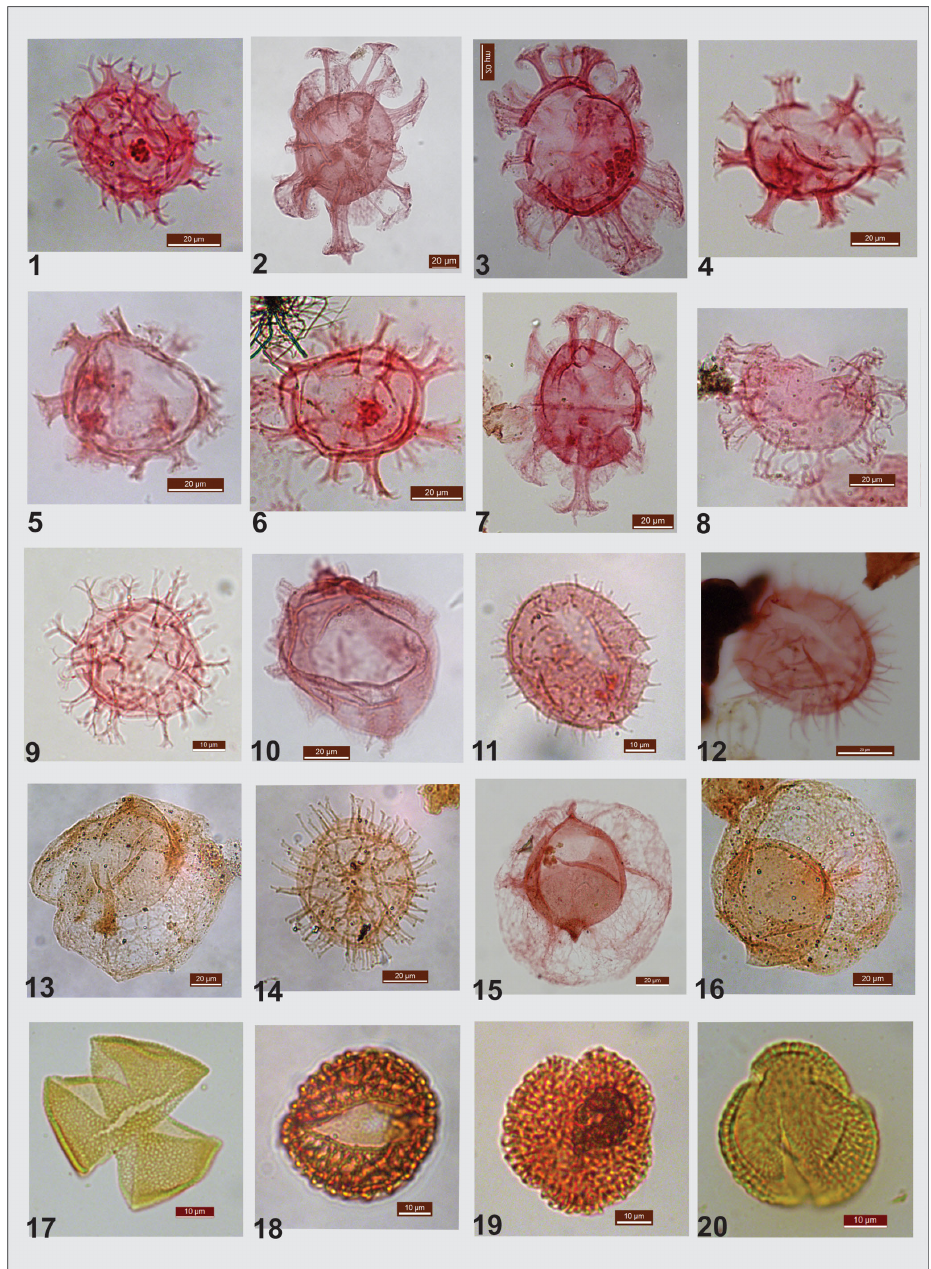
Plate 2. The palynomorph assemblage from Middle Eocene lignite mine sections of the Panandhro and Matanomadh: panel (1) is Achomo- sphaera sp. Panels (2) and (3) are Cordosphaeridium exilimurum . Panels (4) , (5) and (6) are Homotryblium floripes . (6) Glaphyrocysta exuberans . (7) Cordosphaeridium cantharellus . (8) Glaphyrocysta exuberans . (9) Spiniferites ramosus . (10) Kenleyia sp. Panels (11) and (12) are Operculodinium centrocarpum . (13) Thalassiphora pelagica . (14) Polysphaeridium subtile . (15) Thalassiphora fenestrata . (16) Tha- lassiphora pelagica . (17) Dipterocarpuspollenites retipilatus . Panels (18) and (19) are Albertipollenites crassireticulatus . (20) Tricolpites